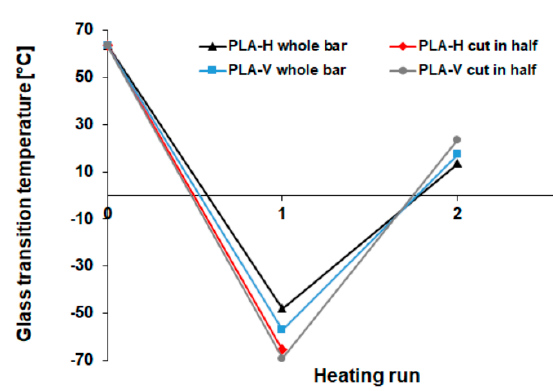
Figure 5. T g shift of PLA dumbbell-shaped specimens obtained by 3D printing in horizontal (H) and vertical (V) directions in subsequent heating runs.